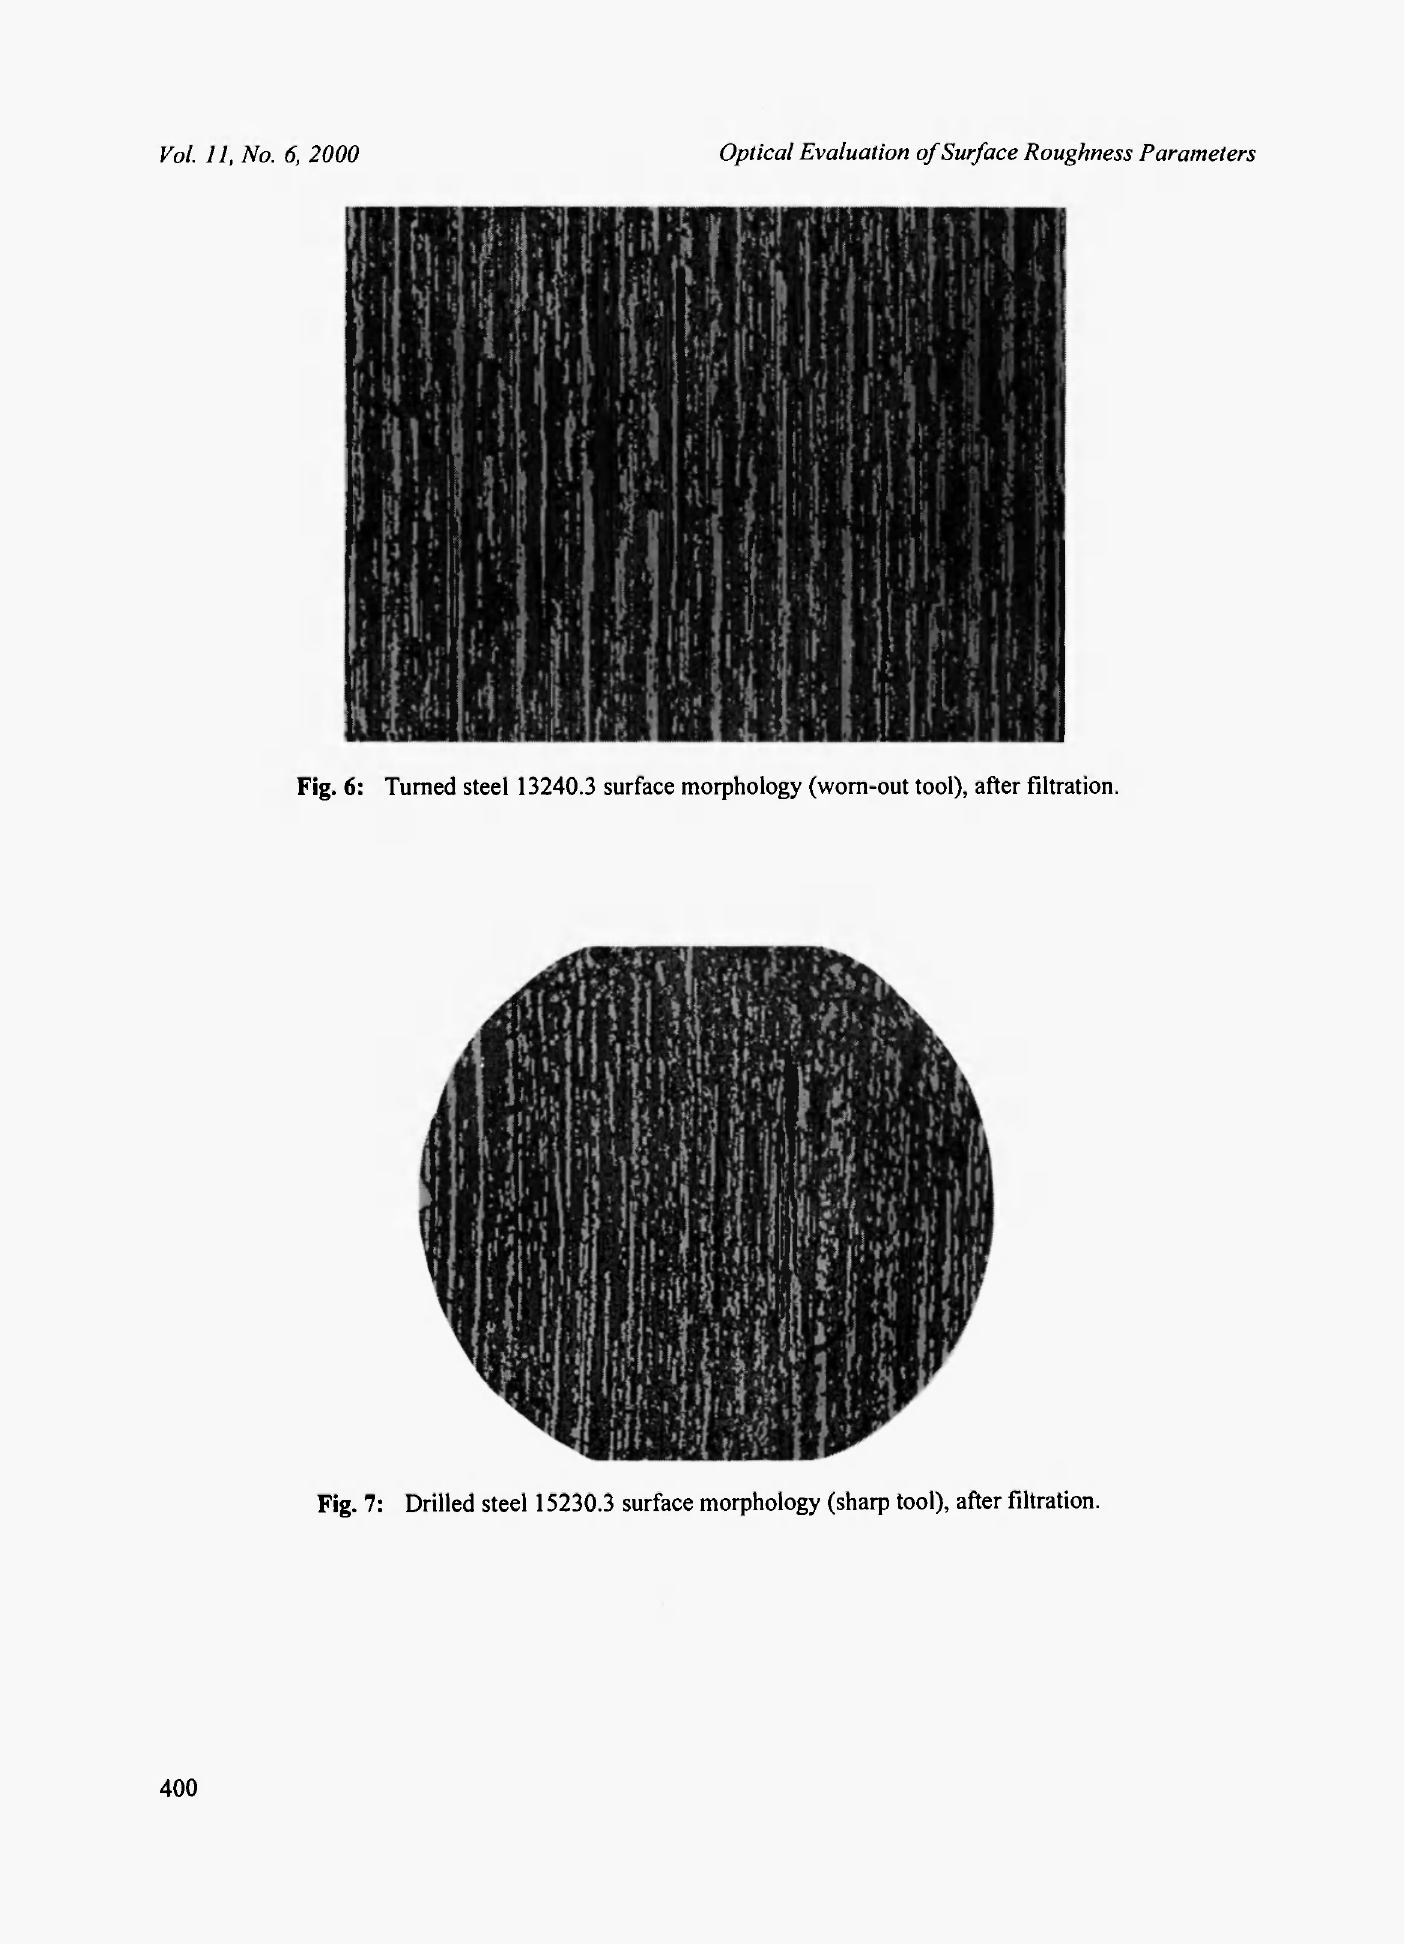
Fig. 7: Drilled steel 15230.3 surface morphology (sharp tool), after